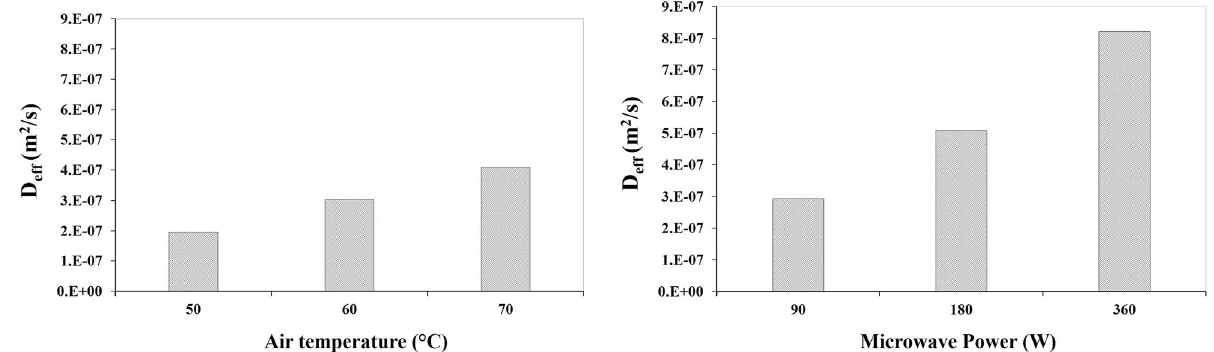
Figure 3. Effective moisture diffusivity ( D eff ) for drying of apple slice in different: ( a ) air temperature, ( b ) microwave power.